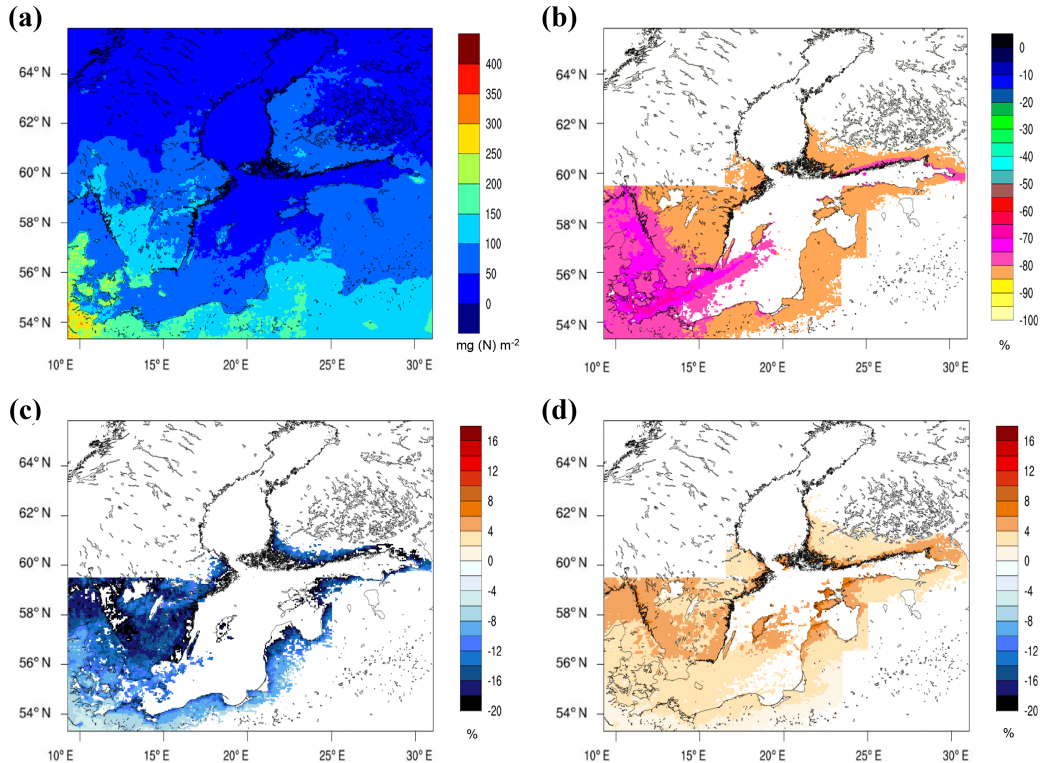
Figure 11. Nitrogen deposition in summer (JJA) 2040: (a) accumulated total deposition of nitrogen (in mg ( N ) m − 2 ) in scenario BAU 2040, (b) percentage change in the ship contribution to nitrogen deposition in scenario BAU 2040 compared to the present day, (c) effect of the NECA on nitrogen deposition, and (d) effect of the lower efficiency of EEDI on nitrogen deposition. Not coloured (empty) areas indicate grid cells with ship contribution in BAU 2040 of less than 6.0mg ( N ) m − 2 for total nitrogen deposition. The ship-related contribution is only shown for the high-resolution area. Table 4. Future (2040) annual and seasonal nitrogen deposition amounts (ktN) to the seawater of the Baltic Sea and ship-related nitrogen deposition according to scenario BAU 2040, taken from the CD04 grid. Values in brackets denote the change (in ktN) compared to 2012. Amounts refer to a Baltic Sea surface area of 431390km 2 , including the western part of